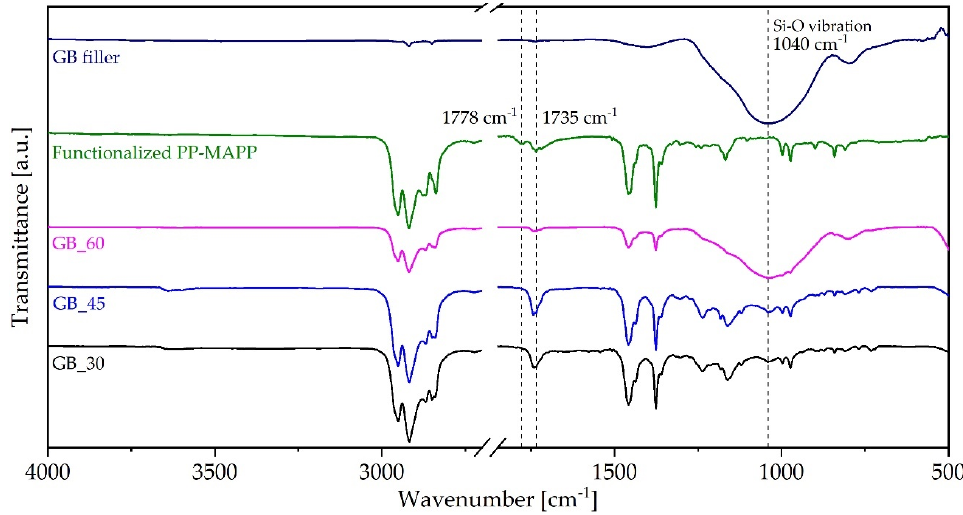
Figure 13. ATR-FTIR spectra of GB materials, reference binder system, and GB filler material.